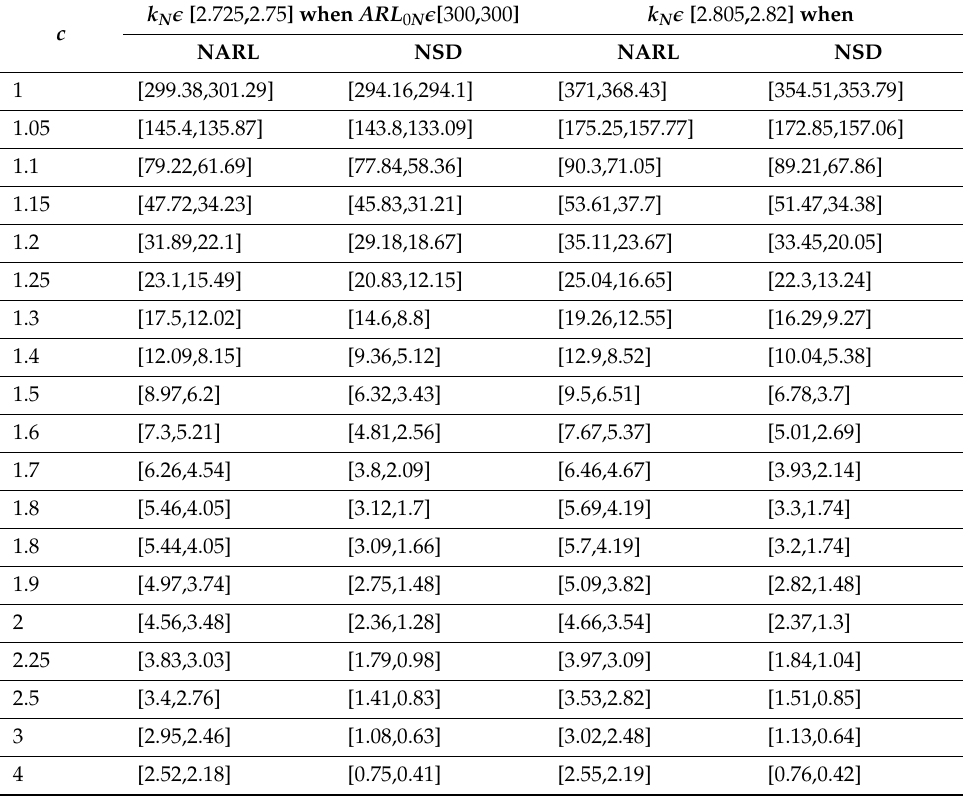
Table 3. The neutrosophic average run length (NARL) when n N (cid:15) [3, 5] and λ N (cid:15) [0.18, 0.22]. c